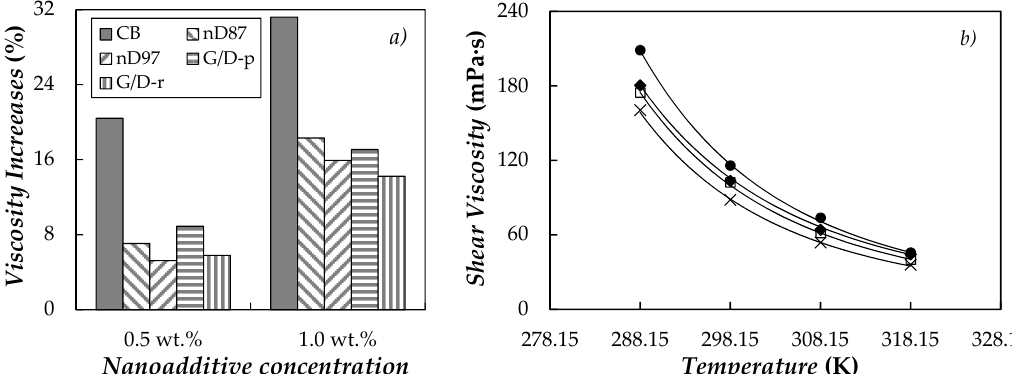
Figure 6. ( a ) Modifications in shear viscosity regarding neat PEG400 at ~100 s − 1 and 298.15 K. ( b ) Temperature dependence of shear viscosity obtained at ~100 s − 1 for neat PEG400 ( × ) and nanofluids prepared at the highest nanoparticle concentration, 1.0 wt.%, of ( ) CB, ( ) nD87 and ( ) G/D-p. (Solid lines) Vogel-Fulcher-Tammann-Hesse, Equation (3).